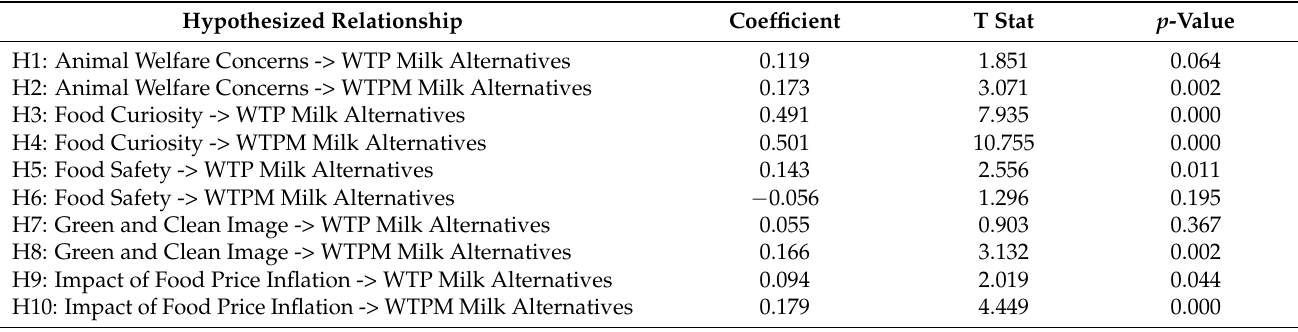
Table 4. Results of hypothesis